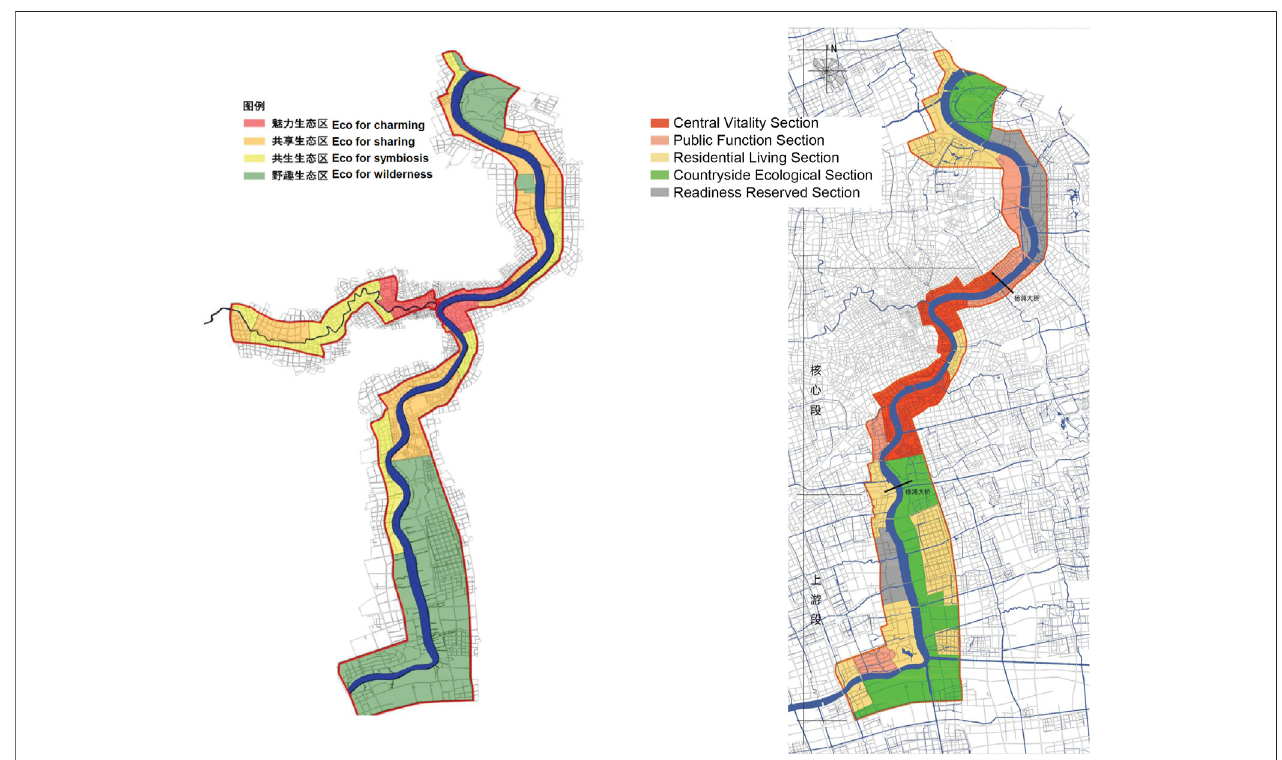
FIGURE5|(A) ProposalforecologicaldimensionsalongtheHuangpuRiver(Source:Ganetal.,2018). (B) FunctionalzonesalongtheHuangpuRiveraccordingto municipal planning bureau (Source: SPLRA, 2018a).